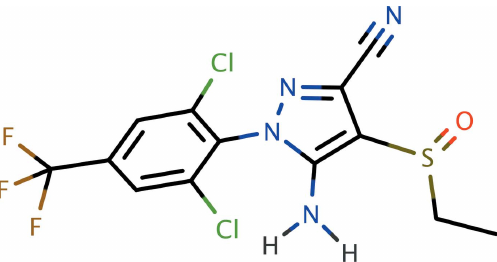
Table 1 Selected torsion angles ( (cid:3) ) in ethiprole.